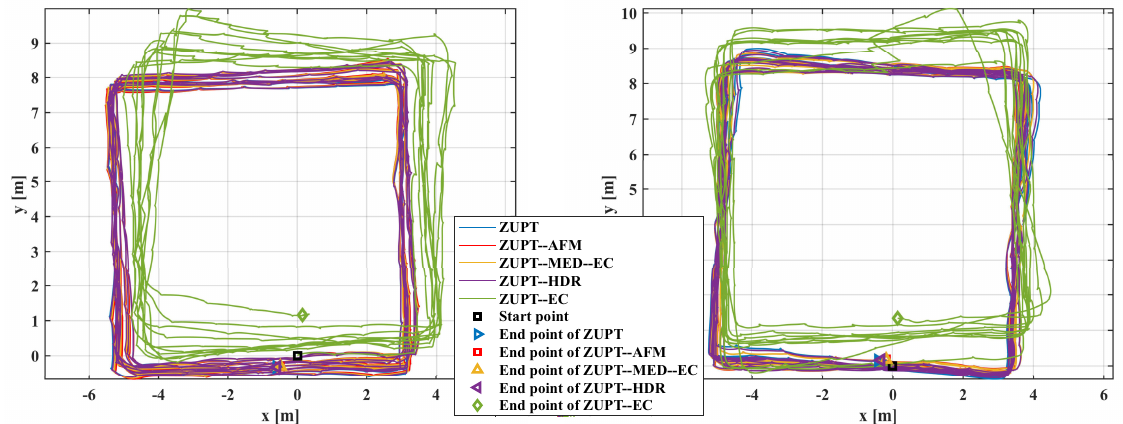
Figure 10. Estimated trajectories of different frameworks on indoor dataset